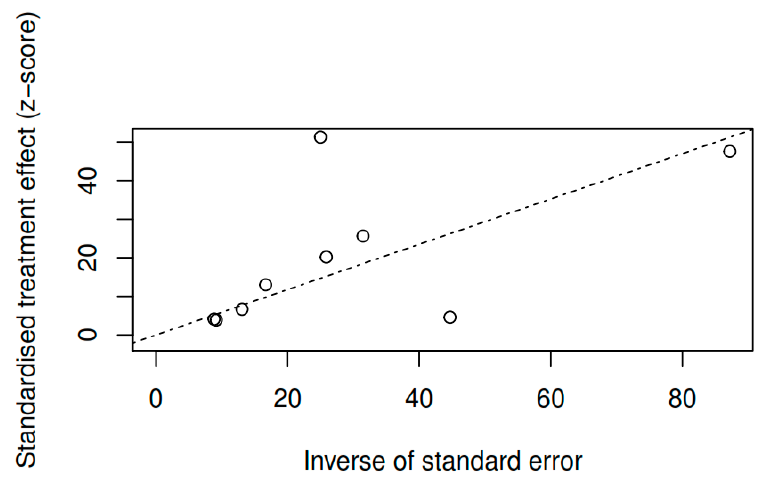
Figure 11. Funnel plot of the negative symptoms variable (pretest–posttest). Int. J. Environ. Res. Public Health 2020 , 17 , x FOR PEER REVIEW